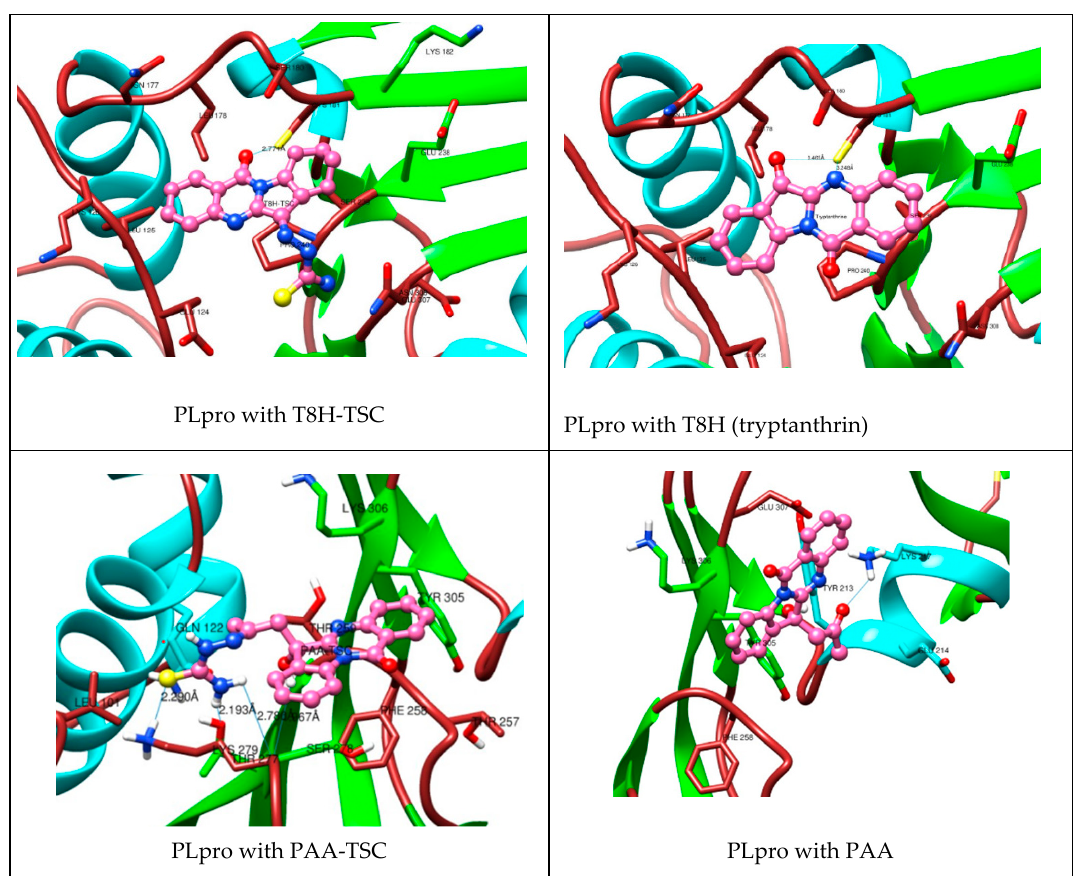
Figure 12. Comparison of complexes PLpro with tryptanthrin derivates (TSC compounds) ( left ) with tryptanthrin and PAA ( right ). During the creation of the magnified image, the hydrogen atoms were hidden for aesthetic reasons.